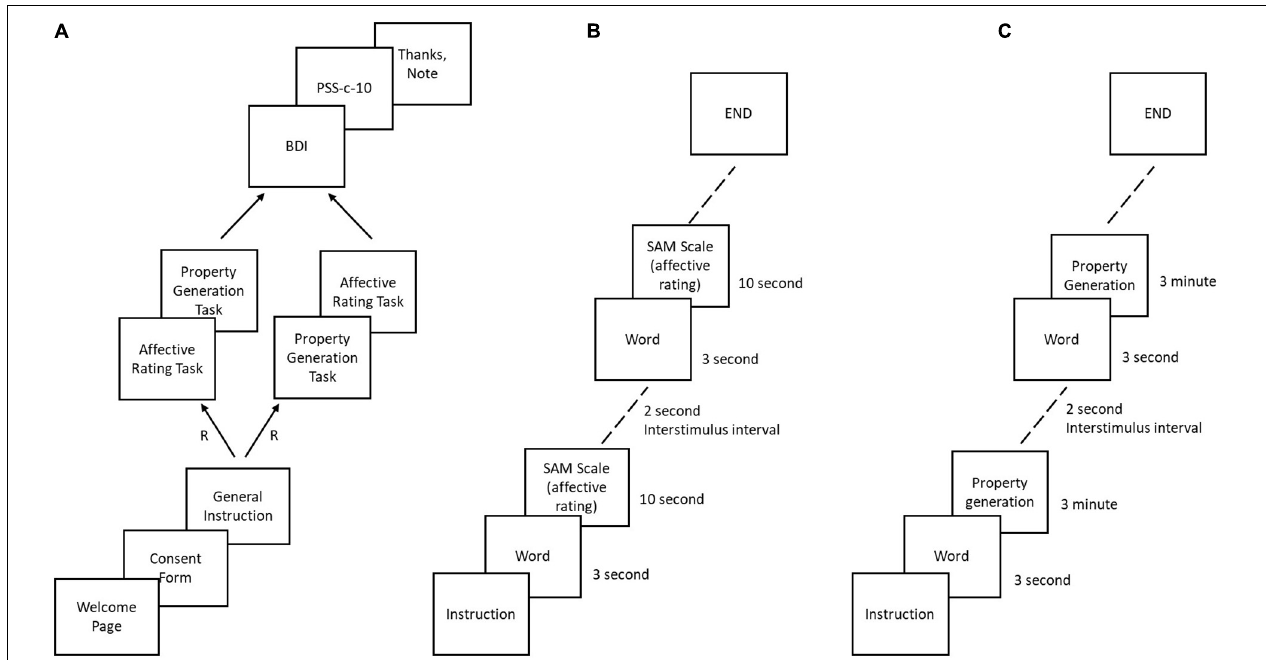
FIGURE 1 | (A) Overall schematic flow of the experiment. R = random assignment (B) Schematic flow of affective rating task (C) Schematic flow of property generation task.